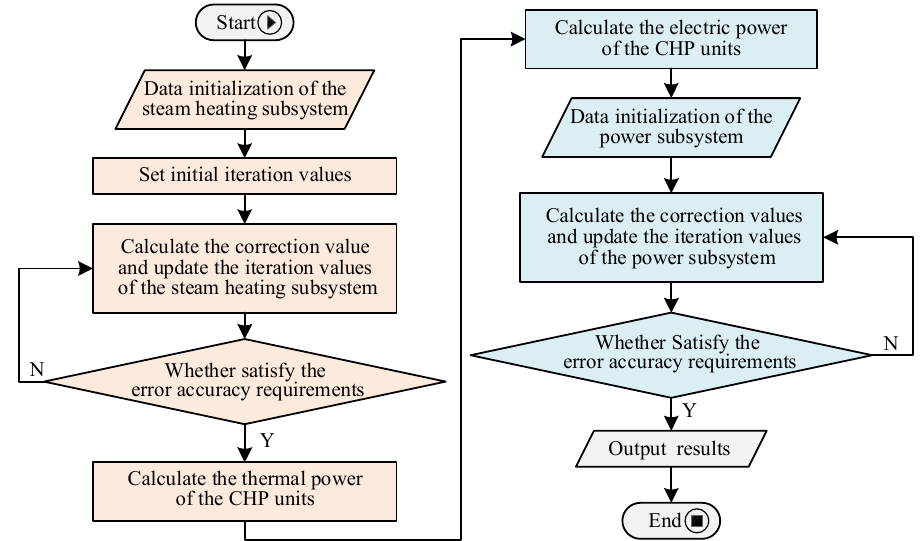
Figure 8. Computation framework of CESS with a back-pressure unit only.